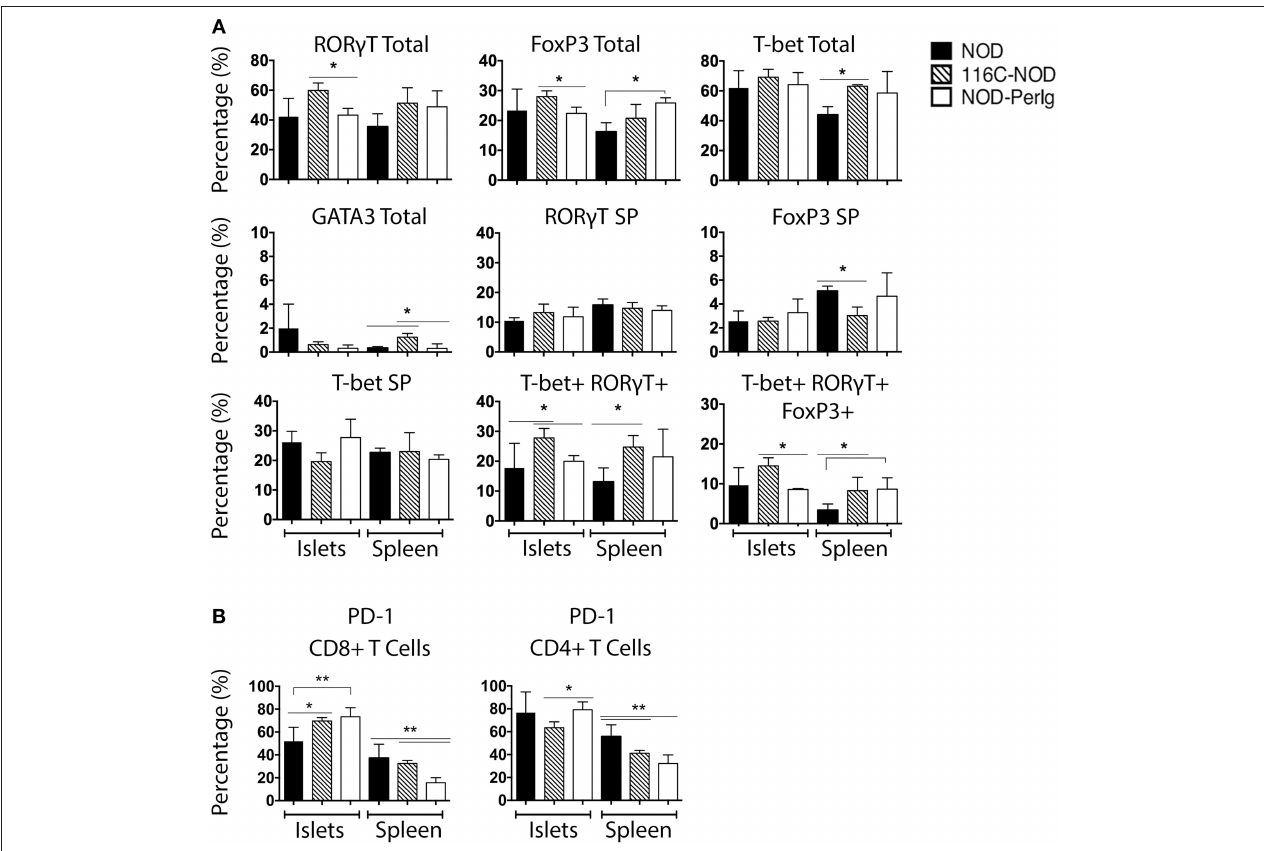
FIGURE 3 | Phenotype of unstimulated splenic and islet infiltrating NOD, 116C-NOD, and NOD- PerIg T-lymphocytes. (A) T-bet, ROR γ t, GATA3, and FoxP3 expression was assessed by flow cytometry in splenic and islet-infiltrating T-lymphocytes from 6-week-old female NOD, 116C-NOD and NOD- PerIg mice ( n = 4 per group, with two replicates for each experimental condition). “Total” and “SP” stand for the percentage of “whole positive” and “single positive” cells for the aforementioned marker, respectively. (B) Expression of PD-1 was analyzed by flow cytometry in the spleen and islet-infiltrating T-lymphocytes from 6-week-old female NOD, 116C-NOD and NOD- PerIg mice ( n = 4 per group, with two replicates for each experimental condition). Bars show the SD of the percentage values. Mann-Whitney U, statistically significant differences: * P < 0.05 or ** P < 0.01.